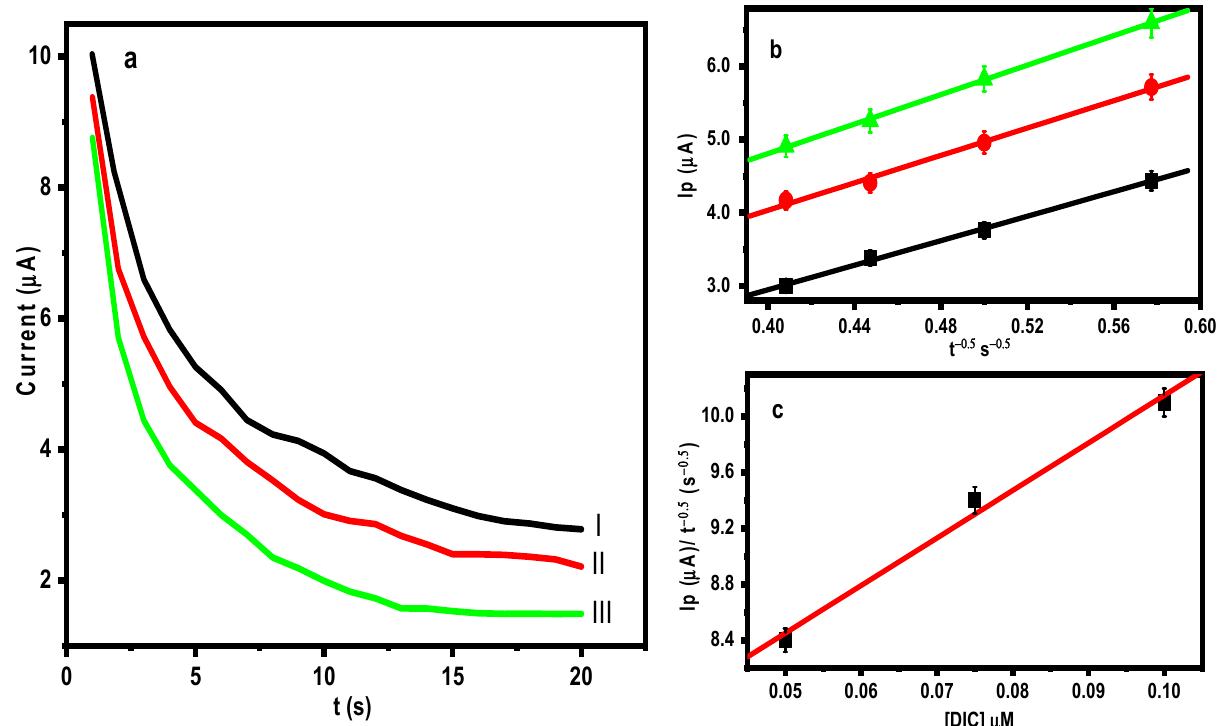
Figure 9. ( a ) Chronoamperogram results of M-Chs NC/CPE in 0.1 M of BR buffer (pH = 3) containing (I) 0.05 µ M, (II) 0.075 µ M, and (III) 0.1 µ M of DIC. ( b ) Dependence of Ip on the t − 1/2 derived from the chronoamperogram data, and ( c ) the plot of the corresponding slopes against the DIC concentration.